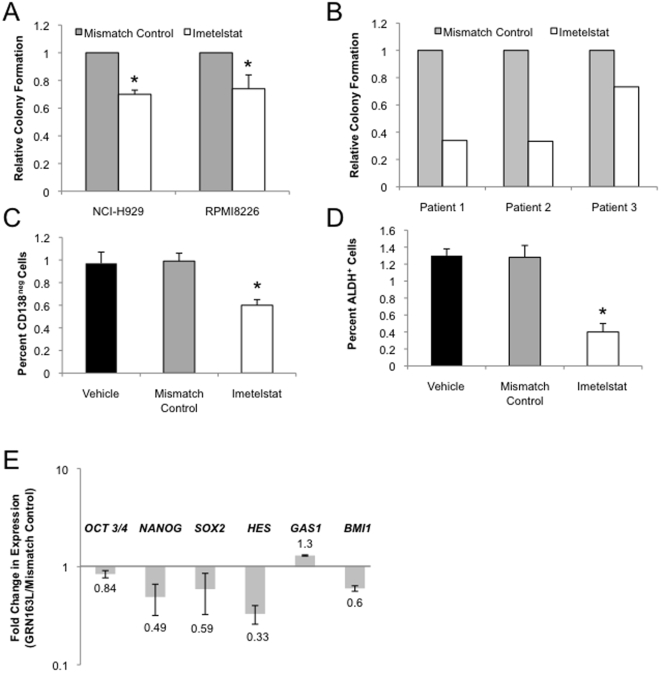
Short-term TA inhibition reduces MM CSC activity and promotes differentiation.(A) Relative clonogenic recovery of CD138neg NCI-H929, RPMI8226, and U266 cells after treatment with vehicle, mismatch control oligonucleotide or imetelstat for 72 hrs (* p-value<0.01). (B) Relative clonogenic recovery of CD138neg cells isolated from primary MM specimens following 72 hrs of treatment with vehicle, mismatch control oligonucleotide or imetelstat (1 uM). (C) Percentage of CD138neg NCI-H929 cells following treatment with imetelstat (1 uM) for 72 hrs (* p-value<0.01). (D) Percentage of ALDH+ NCI-H929 cells following treatment with imetelstat (1 uM) for 72 hrs (* p-value<0.01). (E) Expression of OCT3/4, SOX2, NANOG, HES, GAS1 and BMI1 by CD138neg NCI-H929 cells after 72 hrs of treatment with imetelstat or mismatched control oligonucleotide (1 uM). Data represent fold change in expression relative to mismatch control treated values.